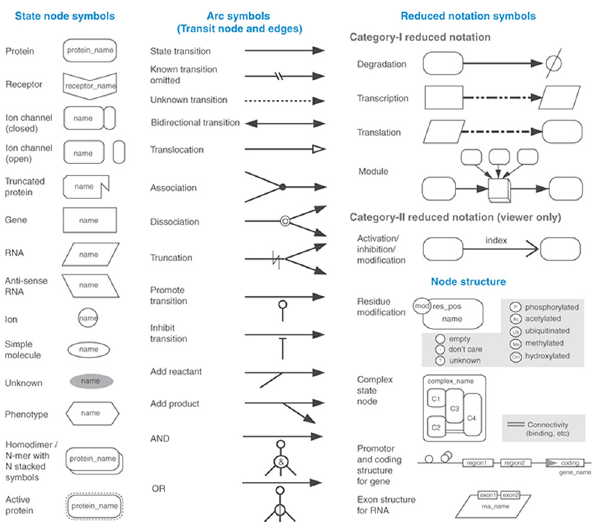
Fig 2. Illustration of the semantically annotated HEPNet. Actual model file is submitted in the SBML file Model in S2 Dataset. Since we are talking of the Human Energy Pool, Mitochondrion is the key organelle. Taylor et al., 2003 [29] said that human mitochondrion is composed of two membranes- outer and inner. In HEPNet, the outer membrane is demarcated in yellow with its inner and outer lining and the inner membrane in magenta with both its inner and outer wall. The reason behind the dual membrane of mitochondrion in HEPNet is to keep up to the actual scenario in a living cell where reactions do take place in the membranes, like